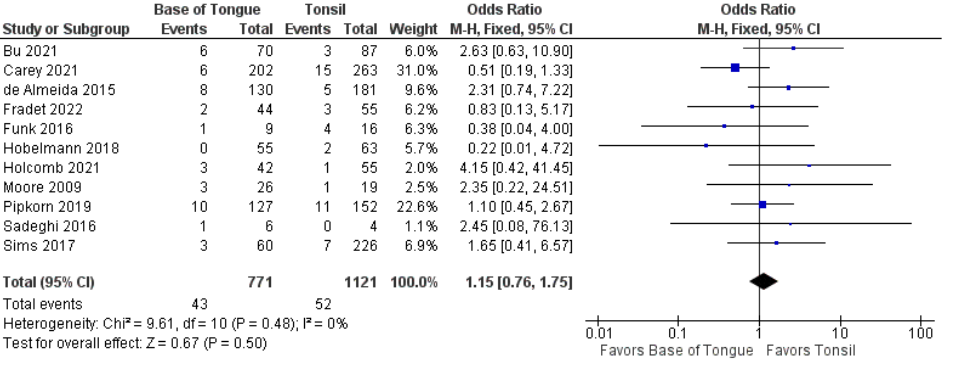
Figure 5. Comparison of locoregional recurrence between tonsillar OPSCC and base of tongue OPSCC.